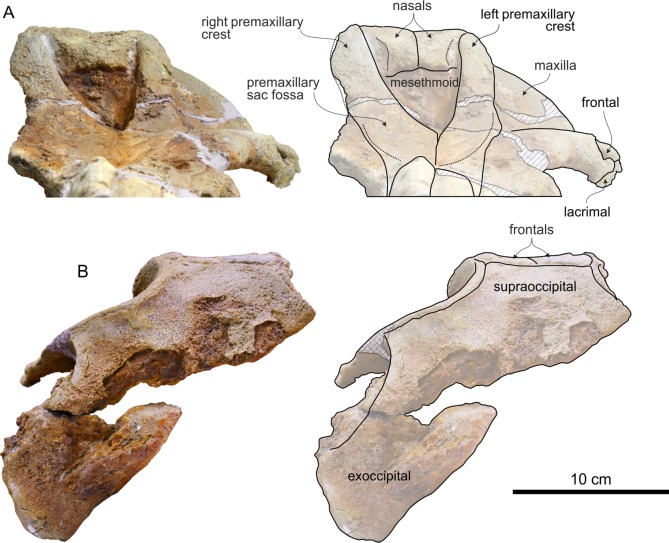
Cranium of Chimuziphius coloradensis in anterior and posterior view.Cranium of the holotype (MUSM 2548) of C. coloradensis, from the Tortonian of Cerro Colorado (Pisco Basin, Peru) in (A) anterior and (B) posterior view. Linear hatching indicates major breaks, crosshatching indicates reconstructed missing parts.